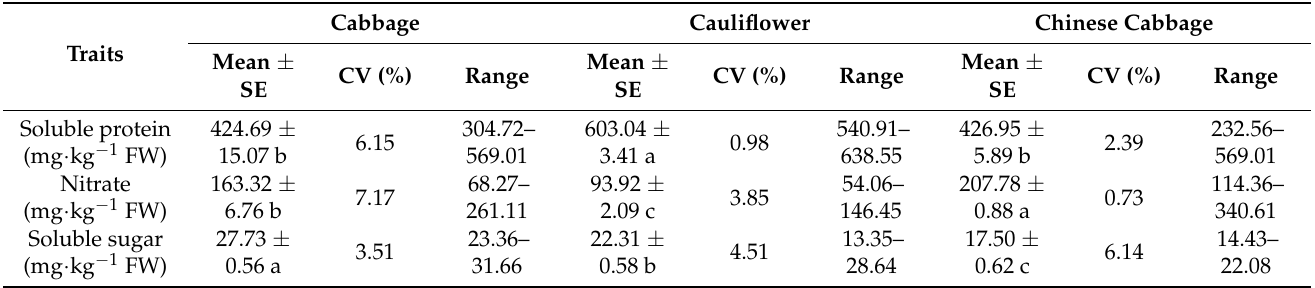
Table 4. Mean ± standard error (SE), range, and coefficients of variation (CVs) for the quality traits in the species analyzed. Species means with different letters are significantly different at p ≤ 0.05.